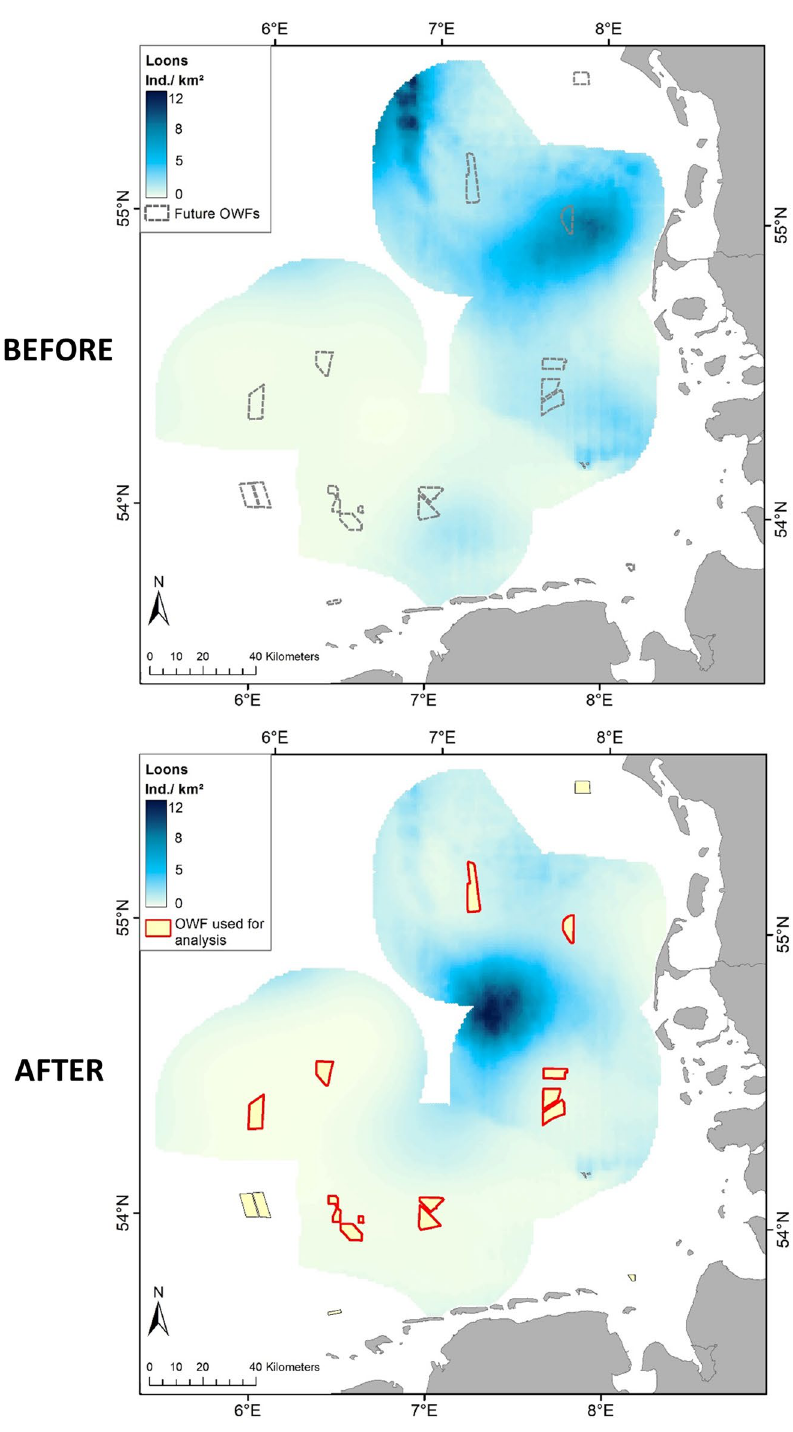
Figure 3. Modelled distribution of loons (individuals per km 2 ) before and after construction of wind farms, combined for all five wind farm clusters. Note that abundance levels differ from those in the single clusters, as shown in Fig. 2. The map was generated in ArcGIS 10.3 for Desktop, https:// www. esri.